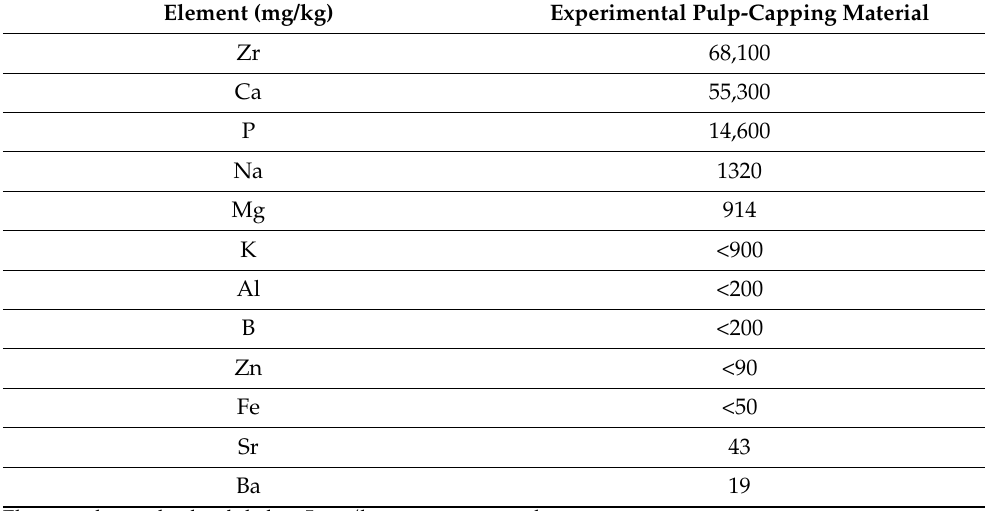
Table 2. Elemental composition of experimental pulp-capping material determined by ICP-MS following digesting in concentrated HNO 3 , HF, and HCI.